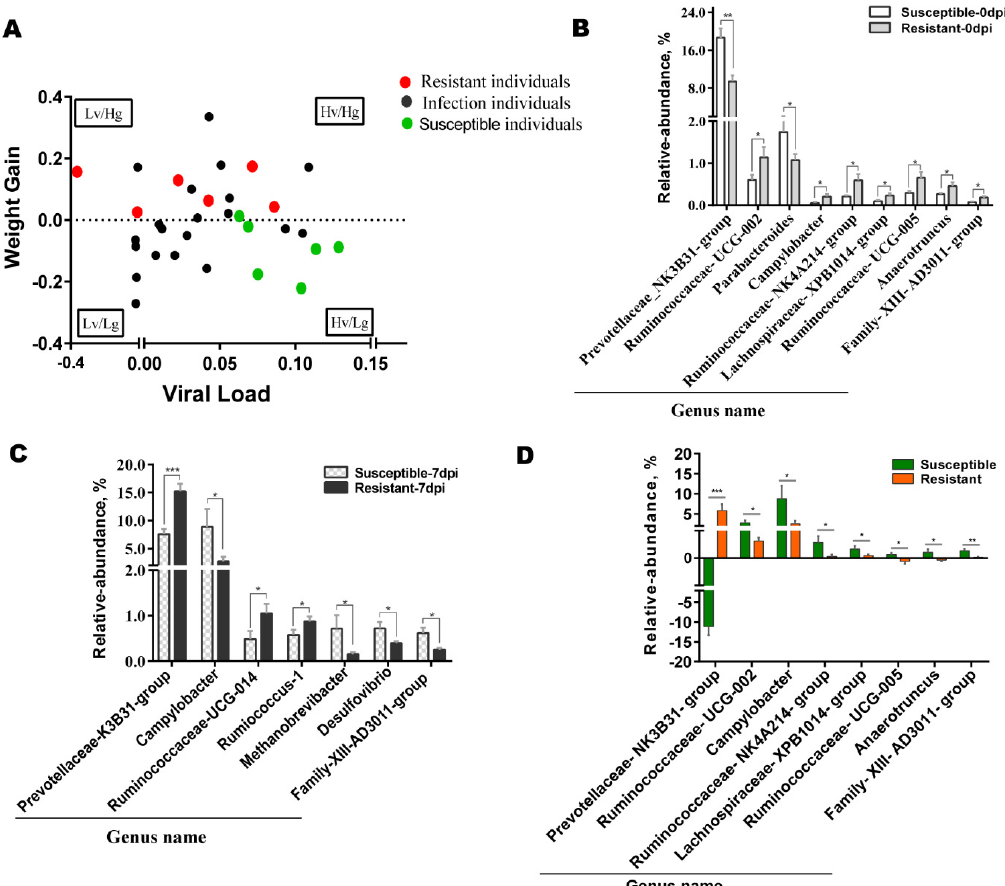
Figure 3. Dynamic change of gut microbiota in susceptible and resistant pigs. ( A ) Viral loadversus weight gain. Hv represents high viral load. Lv represents low viral load. Hg represents high weight gain. Lg represents low weight gain. The red circle represents resistant pigs. The black circle represents experimental pigs. The blue circle represents susceptible pigs. ( B ) Differences of gut microbiota between susceptible and resistant pigs at day 0. ( C ) Differences of gut microbiota between susceptible and resistant pigs at 7 dpi. ( D ) Incremental change in gut microbiota between 7 and 0 dpi. Different letters above the bars denotes significantly differentially abundant genera among groups.